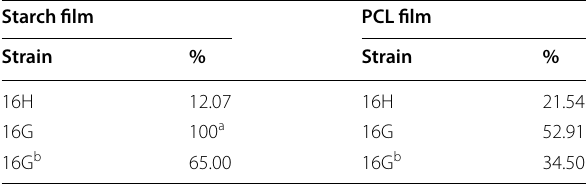
The weight loss of film fragments expressed in % (w/w) a Decomposed after 16 days of growth b